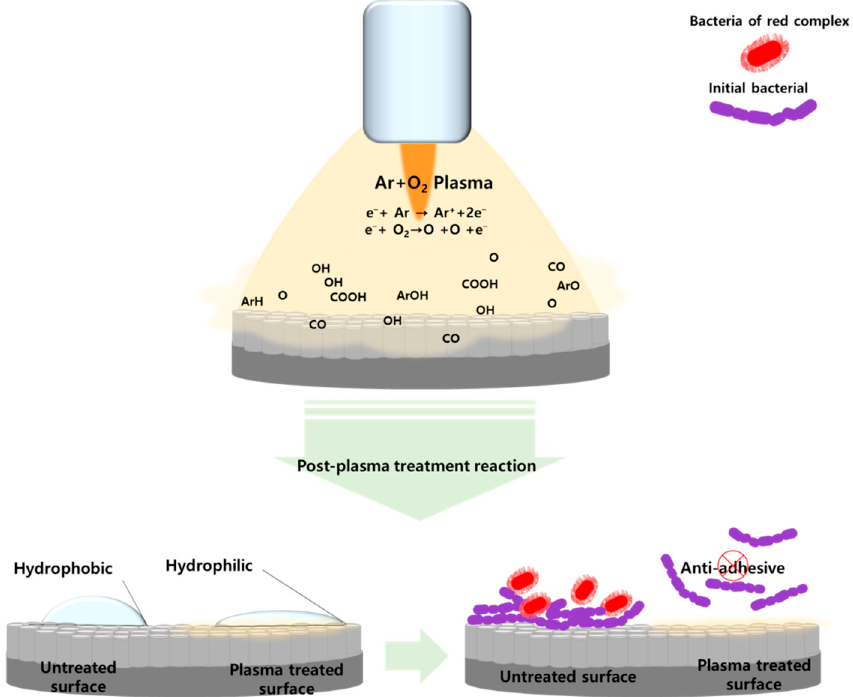
Figure 7. Schematic of a summary of possible events on the plasma-treated TiO 2 nanotube surface. Heat treatment of titanium can modify the crystal structure of the TiO 2 oxide film.